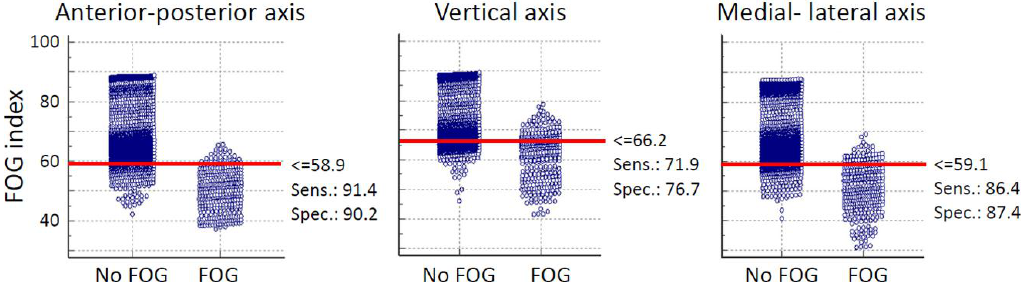
Figure 3. Interactive dot diagram of the FOG index for the shank senor of subject 2 for three different axes. Table 2. Sensitivity, specificity, and area under ROC curve across all the subjects for the different sensor positions with the time window size 4 s and the update time 0.5 s.